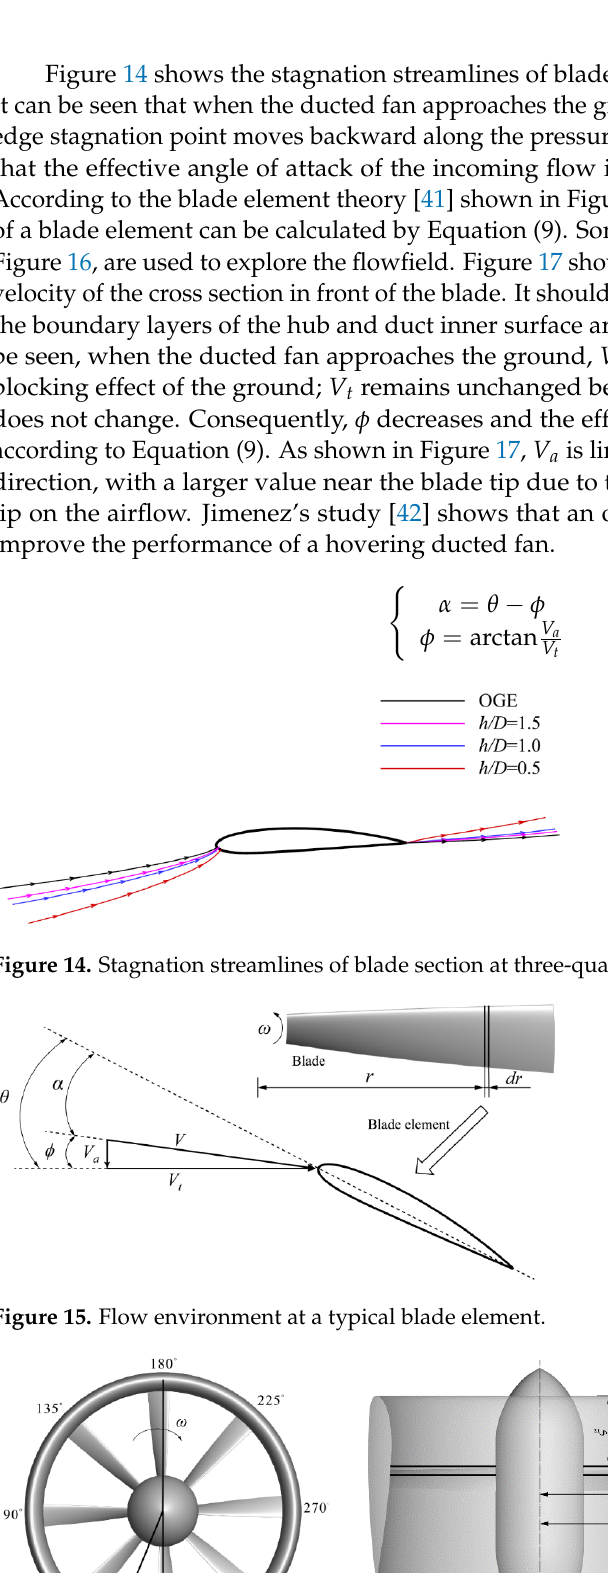
Figure 17. Radial distribution of azimuthally averaged axial velocity on cross section at ξ/c d =0.39.